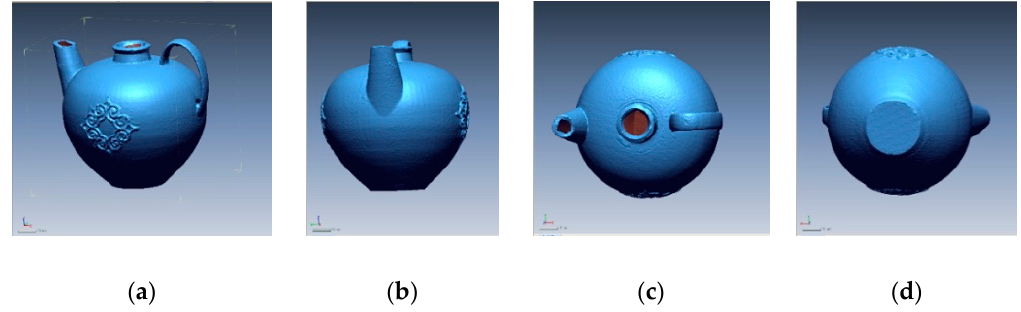
Figure 23. Triangulation model obtained from the 3D scan point cloud data set. ( a ) Front view; ( b ) side view; ( c ) top view; ( d ) bottom view.